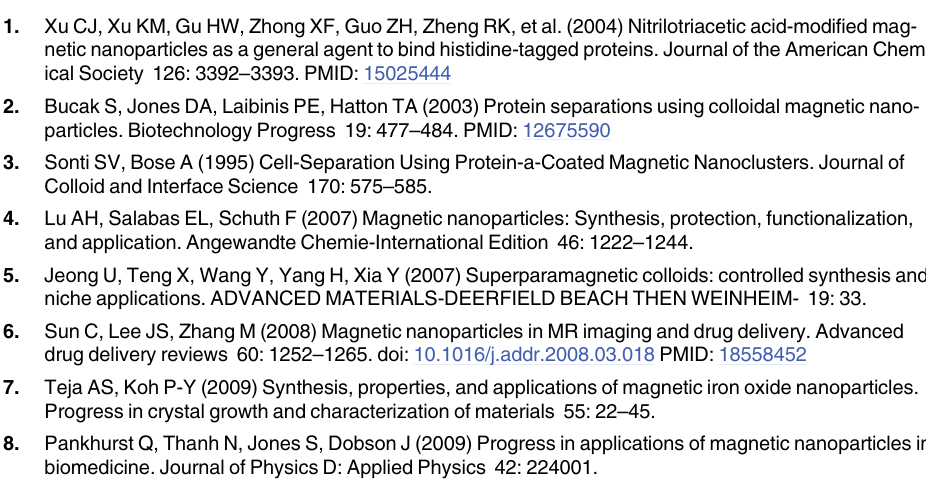
streptomycin. S7 Fig. CCK-8 assay of DL MNPs. The data were obtained after subtracting the measured intensity of control group, i.e. DL MNPs-containing cell